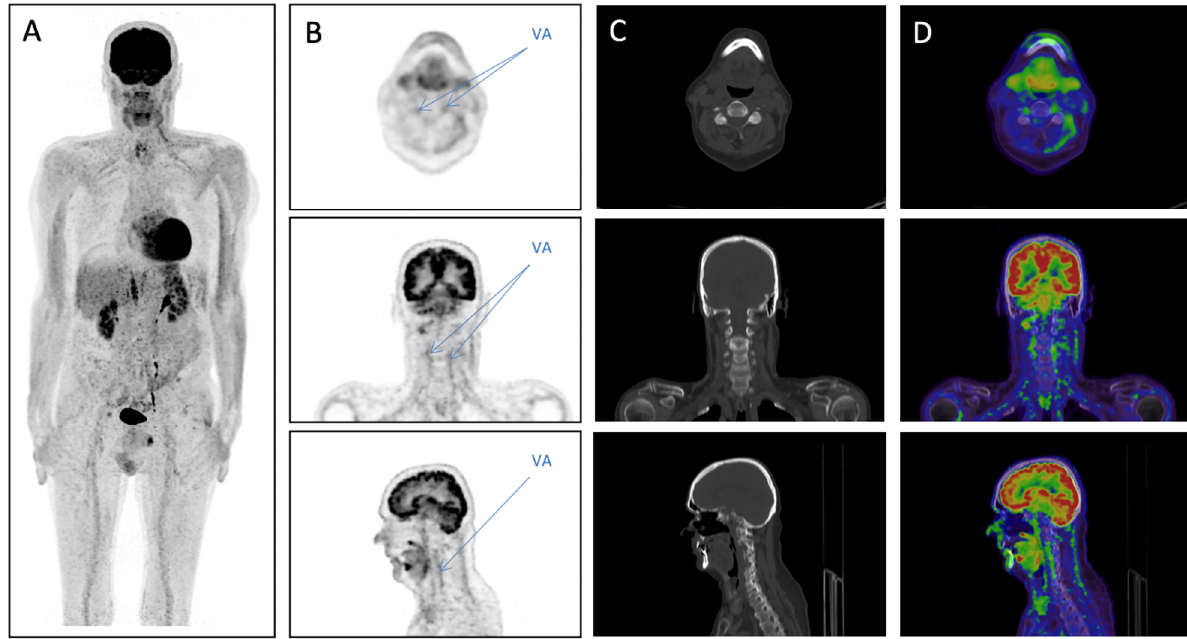
Figure 1. Whole body 2-[ 18 F]FDG PET/low dose CT scan from vertex to the knees 32 days after start of corticosteroid treatment: ( A ) Maximum intensity projection showing normal 2-[ 18 F]FDG uptake in the aorta and its large branches. Poor signal to noise ratio is likely due to ongoing high dose steroid treatment. Columns depict PET ( B ), lowdose CT, bone window ( C ) and fused PET/CT ( D ) in axial (upper row), coronal (middle row) and sagittal (lower row) reconstructions of the head and neck. Blue arrows show visible uptake in the vertebral artery interpreted compatible with giant cell arteritis. A 67-year-old male smoker with chronic obstructive pulmonary disease was referred to the Department of Internal Medicine due to unspecific symptoms including weight loss and pain in the neck and shoulders for three months. C-reactive protein was elevated at 47 mg/L (normal < 10 mg/L). A computed tomography (CT) scan of thorax and abdomen showed